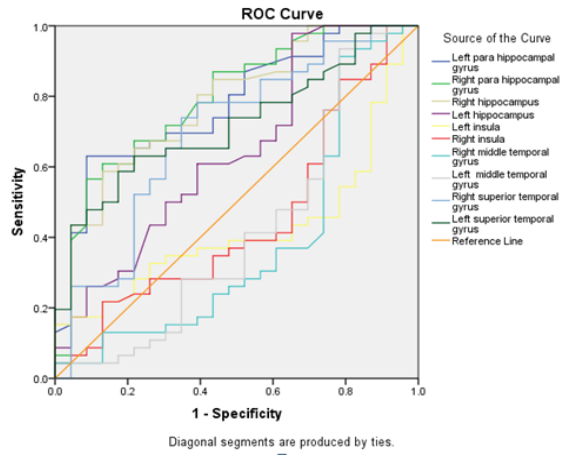
Figure 3 . The ROC Curve for the Identification of the Importance of